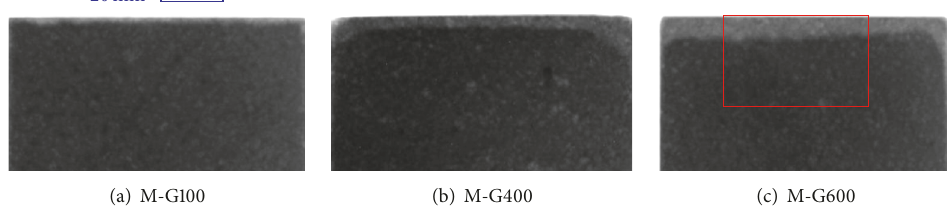
Figure 8: Neutron images as obtained on the tree types of water repellent surface impregnated and water saturated mortar specimens. The upper half of the neutron images taken on square slabs is shown only.